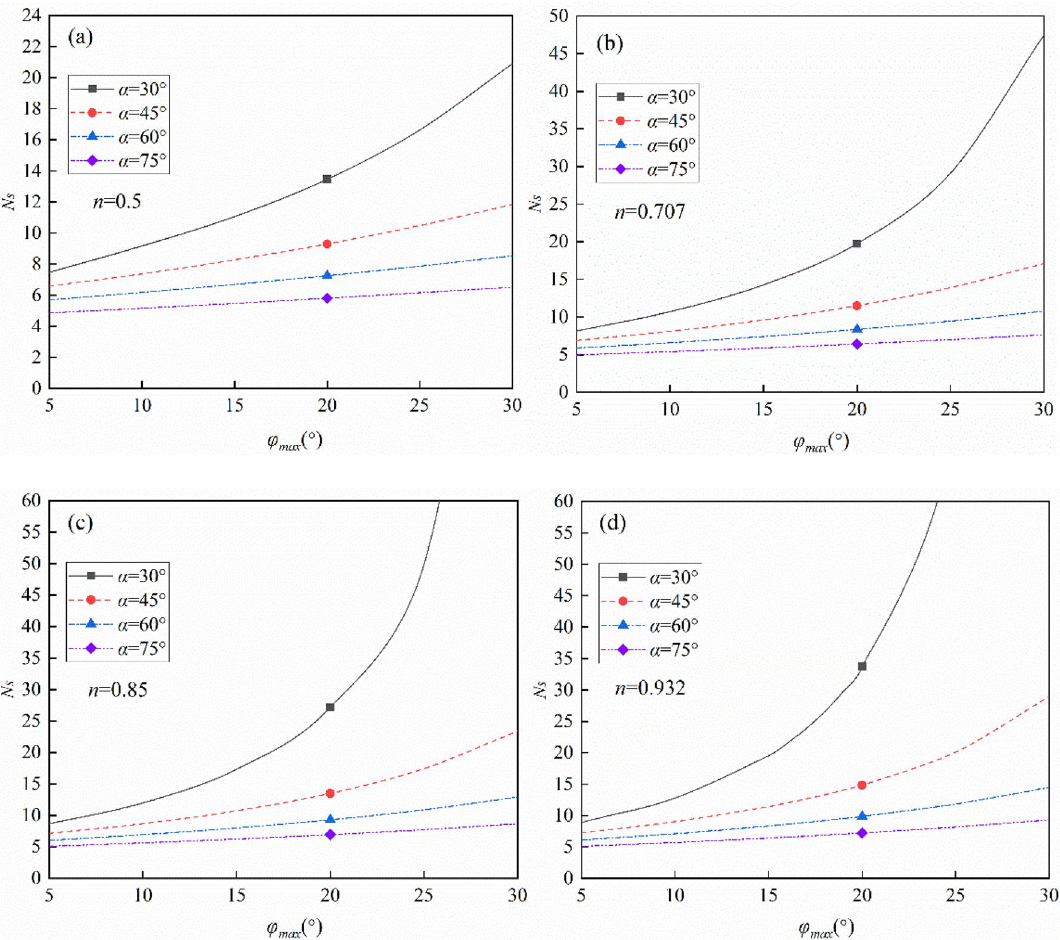
Figure 6. The effect of slope angle α on the stability factor ( β = 25°): ( a ) n = 0.5, ( b ) n = 0.707, ( c ) n = 0.85, ( d ) n = 0.932.